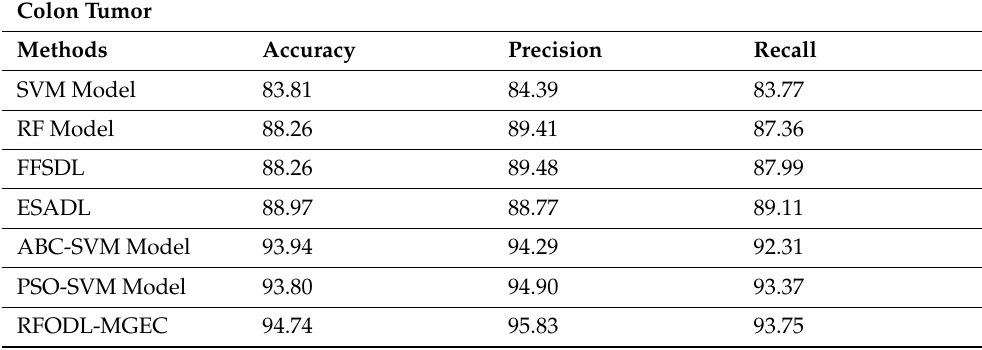
Table 6. Comparative analysis of RFODL-MGEC technique with recent algorithms for colon tumor dataset.